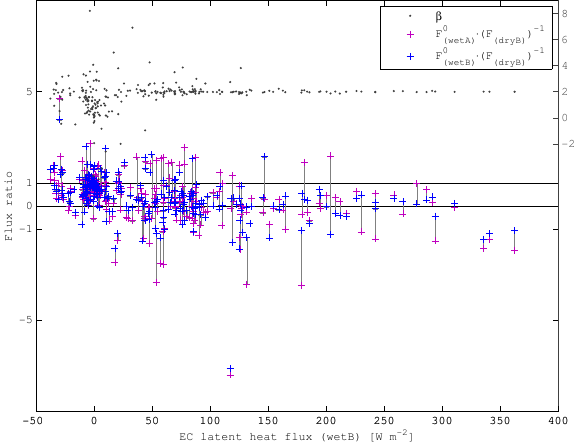
Fig. 10. Bin-averaged heat fluxes plotted against the standard EC sensible heat flux results (to be compared with Fig. 2 in Prytherch et al., 2010a): “sonic flux” calculated from T s (light grey - -); flux after detrending against humidity (black -.); “PKT-corrected” flux (red -); results of a PKT correction with step width 0 . 75 and β ≈ 4 (“PKT 4”) (blue -). Error bars show standard deviation from the mean. 1 : 1, 1 : 2 and 2 : 1 agreement are indicated.